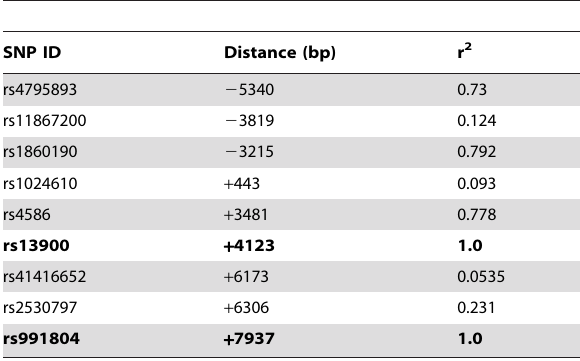
Table 4. Linkage disequilibrium between rs1024611 and other SNPs in the CCL2